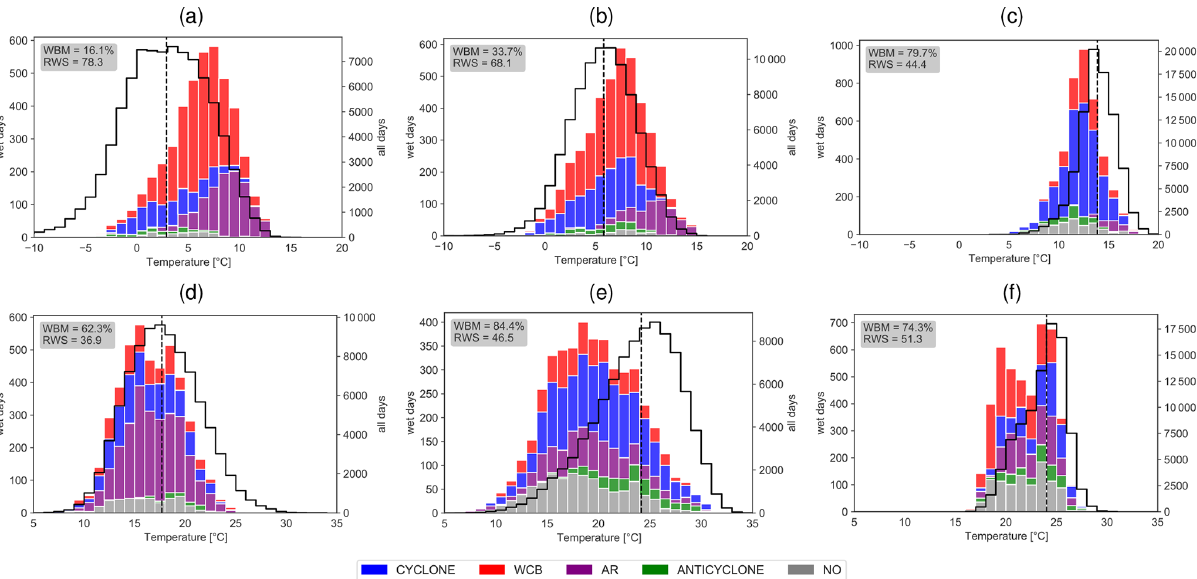
Figure 3. P(T , WS) relationships in winter (a–c) and summer (d–f) for the following regions: C-EU (a, d) , IBP (b, e) , and MED (c, f) . The black curve shows the T distribution of all days (right y axis), and the colours in the stacked bar plots denote the dominant weather system on wet days (left y axis). Values denote counts of grid points in the box where a particular weather system is identified as the dominant one. Note the different scaling of the y axis in the different panels. In the upper left of each panel, values are given for the fraction of wet days below the median of daily mean temperatures (WBM; cf. Fig. 2a and b) and the relevance of weather systems for the P ( T ) relationship (RWS).